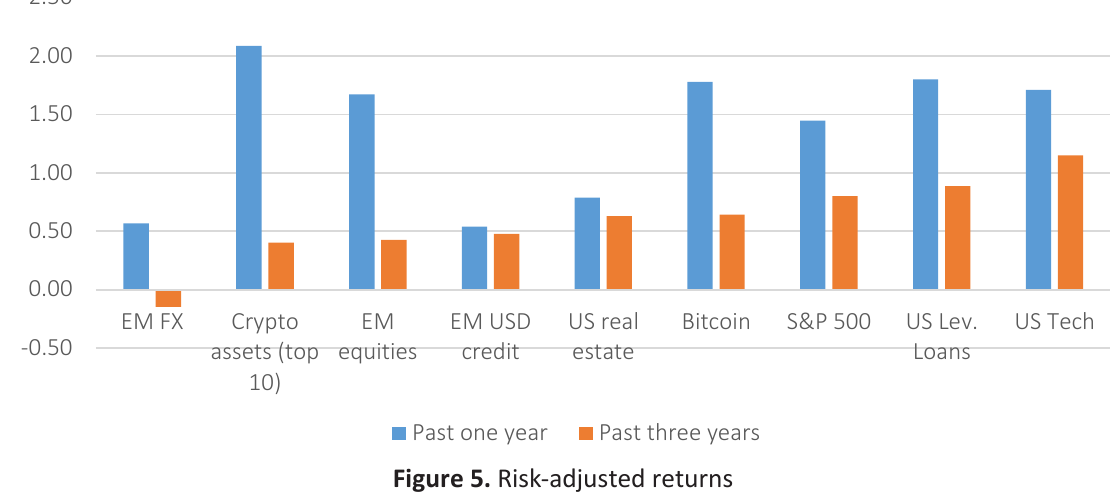
Figure 5. Risk-adjusted